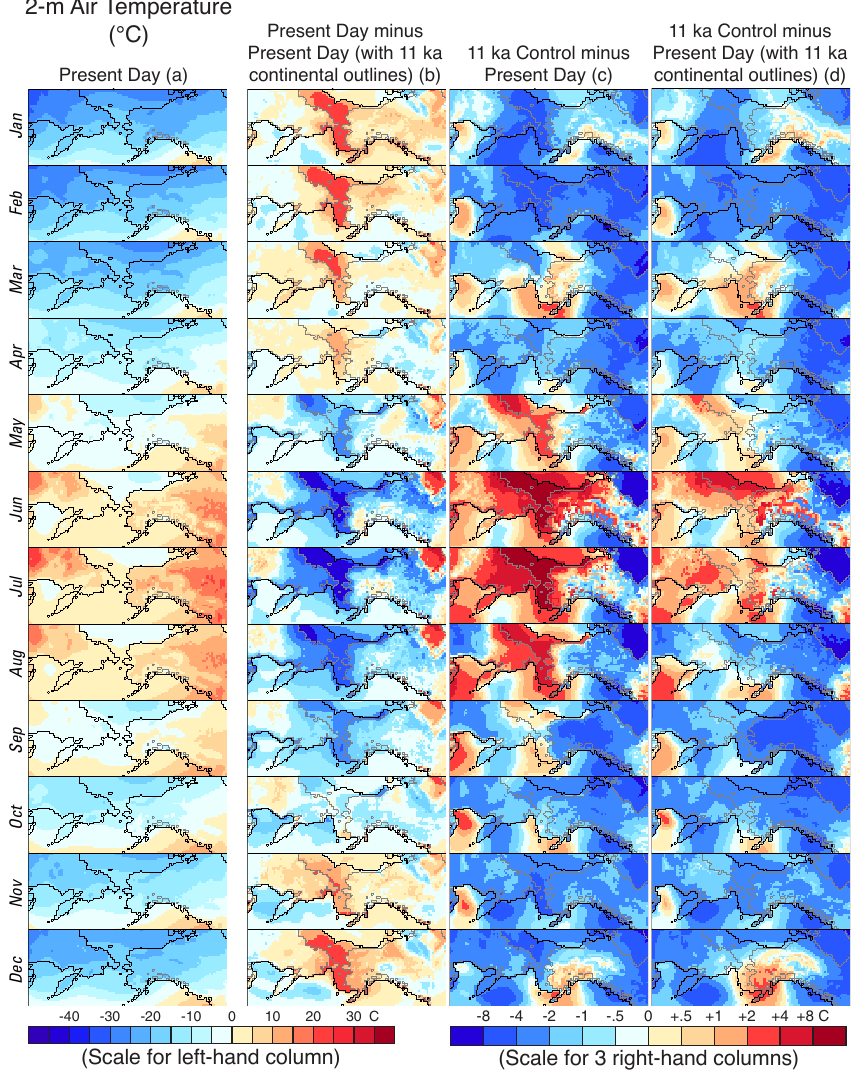
Figure 5. Simulated 2m air temperature. (a) Present Day (0ka) simulation; (b) effect of land-bridge flooding on present-day climatology ( Present Day minus Present Day with 11ka Continental Outlines ); (c) difference between 11ka Control and present ( 11ka Control minus Present Day ); (d) difference between 11ka Control and present as a result of insolation and boundary conditions other than sea level ( 11ka Control minus Present Day with 11ka Continental Outlines ). Ice-sheet and coastal outlines as in Fig.